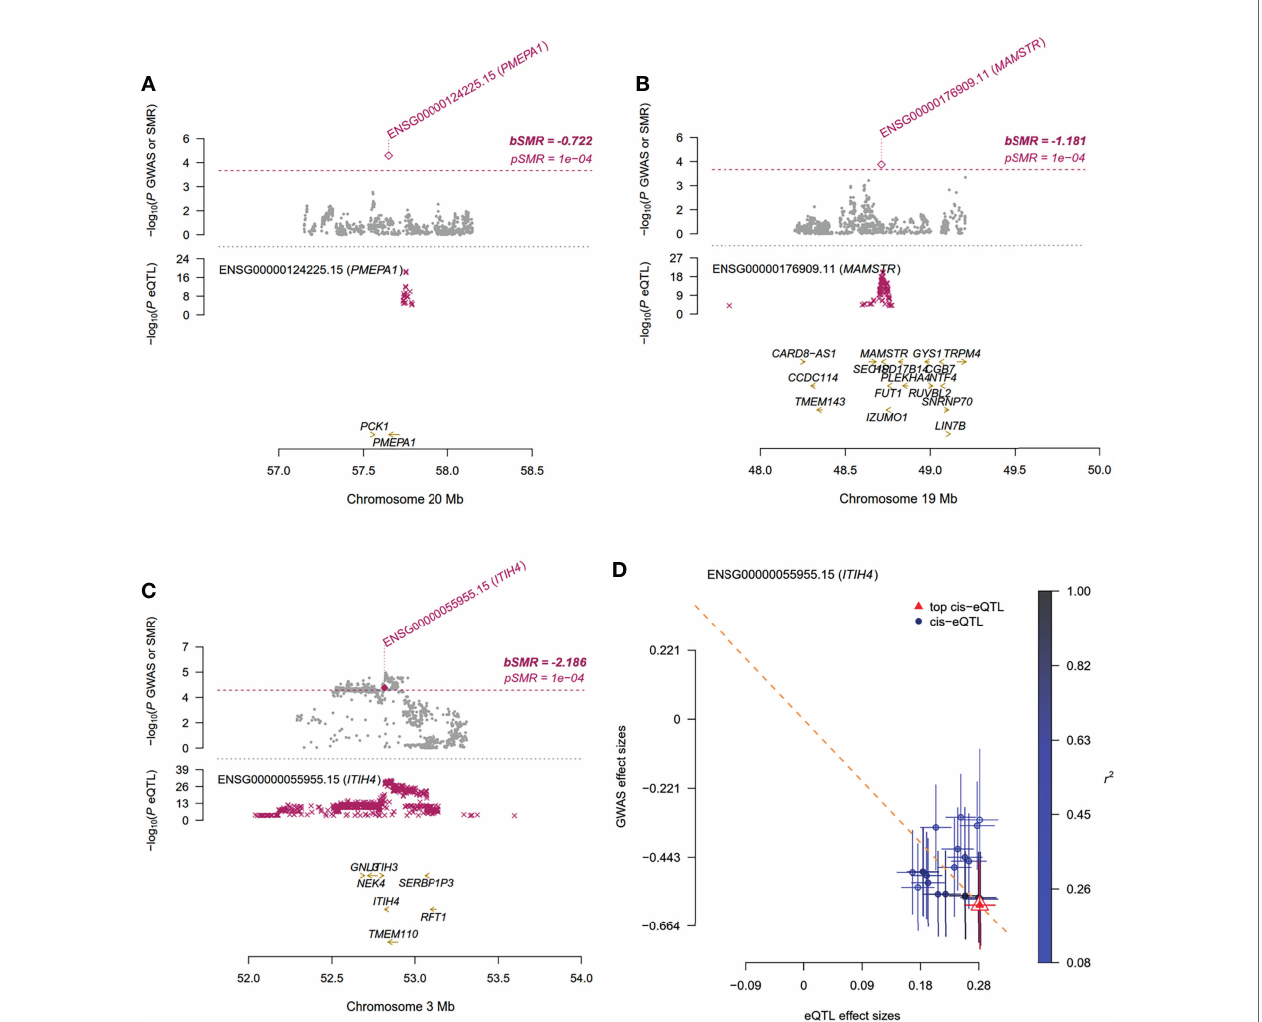
FIGURE 3 | Summary-data-based Mendelian Randomization (SMR) analysis using gene expression quantitative trait loci (eQTL) implicates the role of associated genes in schistosomiasis. For (A – C) Top plot, gray dots represent the P values for SNPs from the GWAS analysis for associated genes (A) PMEPA1 , (B) MAMSTR and (C) ITIH4 , diamonds represent the P values for probes from the SMR test; Bottom plot, the eQTL P values of SNPs from GTEx v8 for the probes tagging associated genes. The top and bottom plots include all the SNPs available in the region in the GWAS and eQTL summary data, respectively, rather than only the SNPs common to both data sets. Highlighted in red is the gene that passed the SMR and HEIDI tests. (D) Effect sizes of SNPs (used for the HEIDI test) from GWAS plotted against those for SNPs from the GTEx v8 eQTL studies. The orange dashed lines represent the estimate of b xy at the top cis-eQTL (rather than the regression line). Error bars are the standard errors of SNP